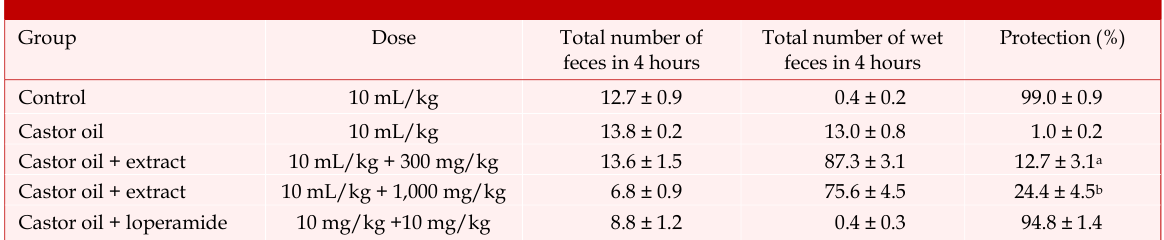
Effect of the crude extract of Vincetoxicum stocksii on castor oil-induced diarrhea in mice